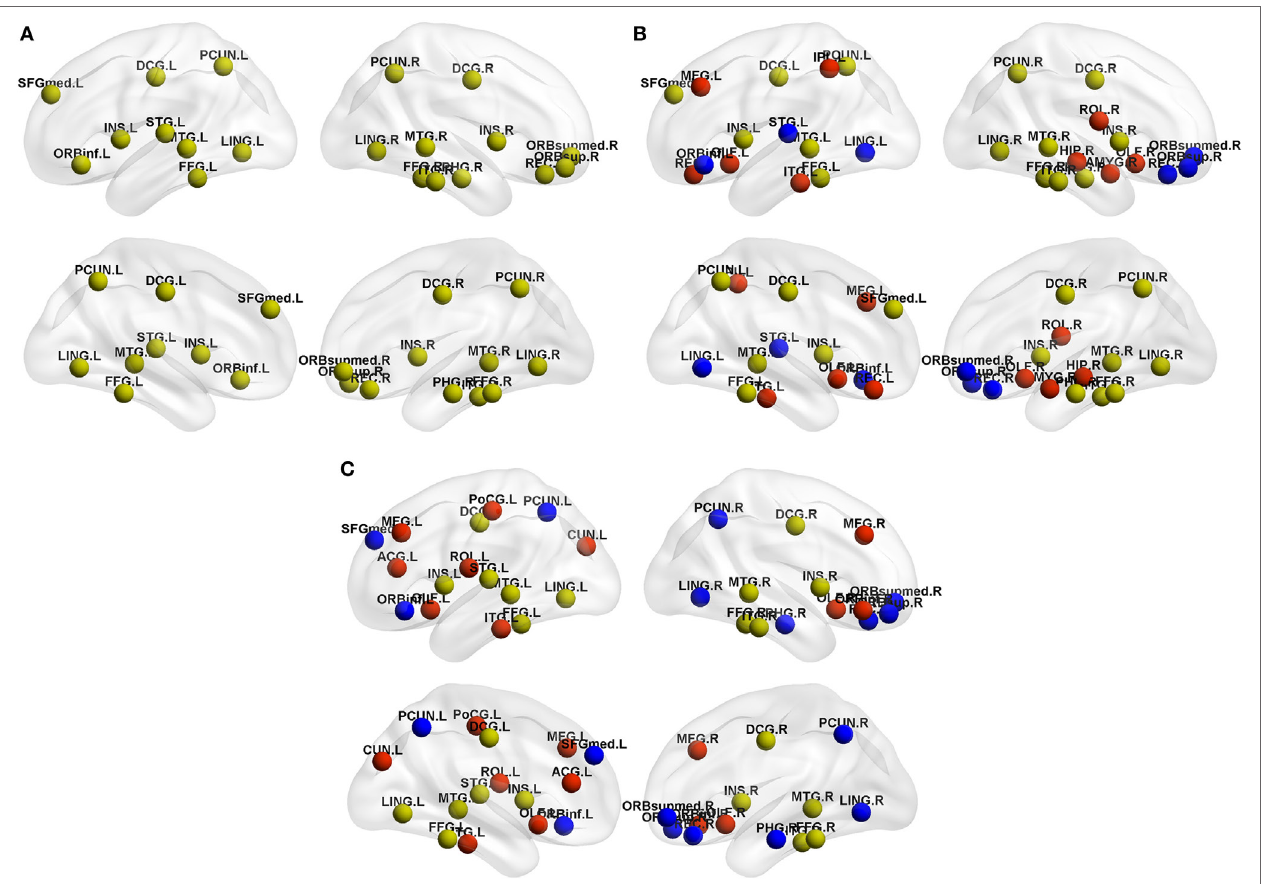
FigUre 4 | Hub distribution of the structural brain network in (a) normal controls (NCs), (B) Parkinson’s disease (PD) patients with possible rapid eye movement sleep behavior disorder (RBD) (PD-pRBD), and (c) PD patients with non-possible RBD (PD-npRBD). Regarding the yellow nodes in NCs as reference, red nodes in PD-pRBD and PD-npRBD groups represented the recruitment nodes, blue nodes in PD-pRBD and PD-npRBD groups represented the lost nodes. The results were visualized using the BrainNet Viewer (Beijing Normal University, http://www.nitrc.org/projects/bnv/). Abbreviations were presented in Table S3 in Supplementary